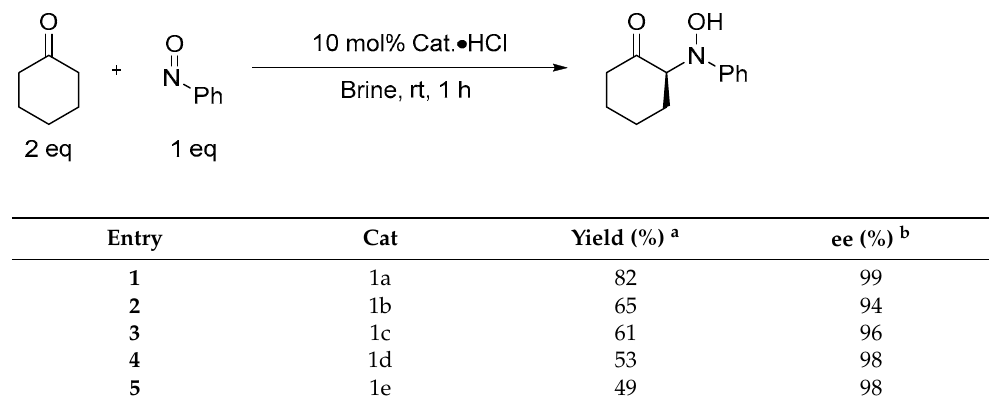
Table 2. Optimization of the nitroso aldol reaction using ( R , R )-1,2-diphenylethylenediamine (DPEN).